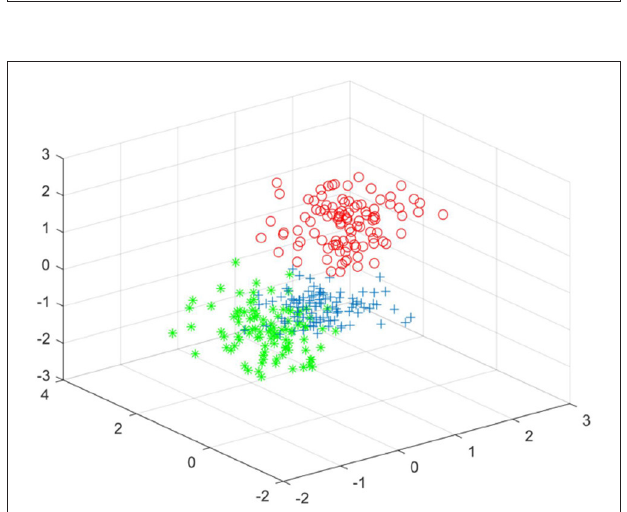
FIGURE 5 | The clustering effect diagram of the completion data of experiment one.